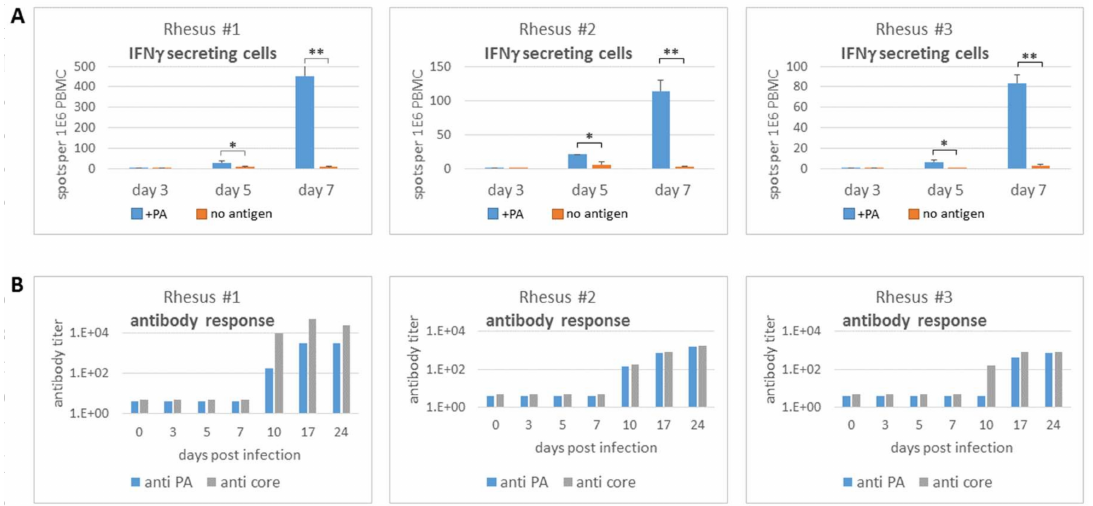
Figure 5. Cellular and humoral response in non-human primates following B. anthracis infection. Three individual animals were infected subcutaneously with 5 × 10 8 spores of Sterne ∆ htrA lefMUT ∆ cya strain. The animals were bled in the indicated time points and their immune response was evaluated by ELISPOT ( A ) and ELISA ( B ) as described in the text. * p < 0.05, ** p <